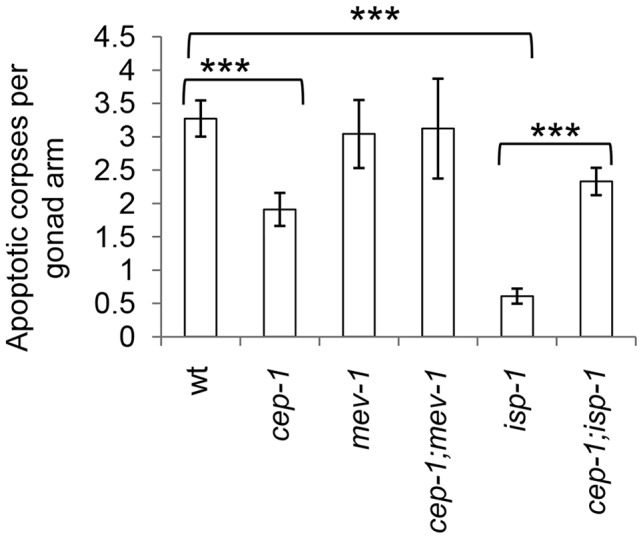
CEP-1 mediates reduced physiological germline apoptosis in the isp-1 mutant.Physiological levels of apoptosis were quantified by counting the number of apoptotic corpses per gonad arm in various C. elegans strains. The corpses were counted using DIC microscopy at 63× magnification 48 hr post L4. The data represent the average of at least 3 independent experimental replicates (n≥15 gonad arms for each) ± standard error. Statistical analysis was done using the Mann-Whitney U-test. ***p<0.001.